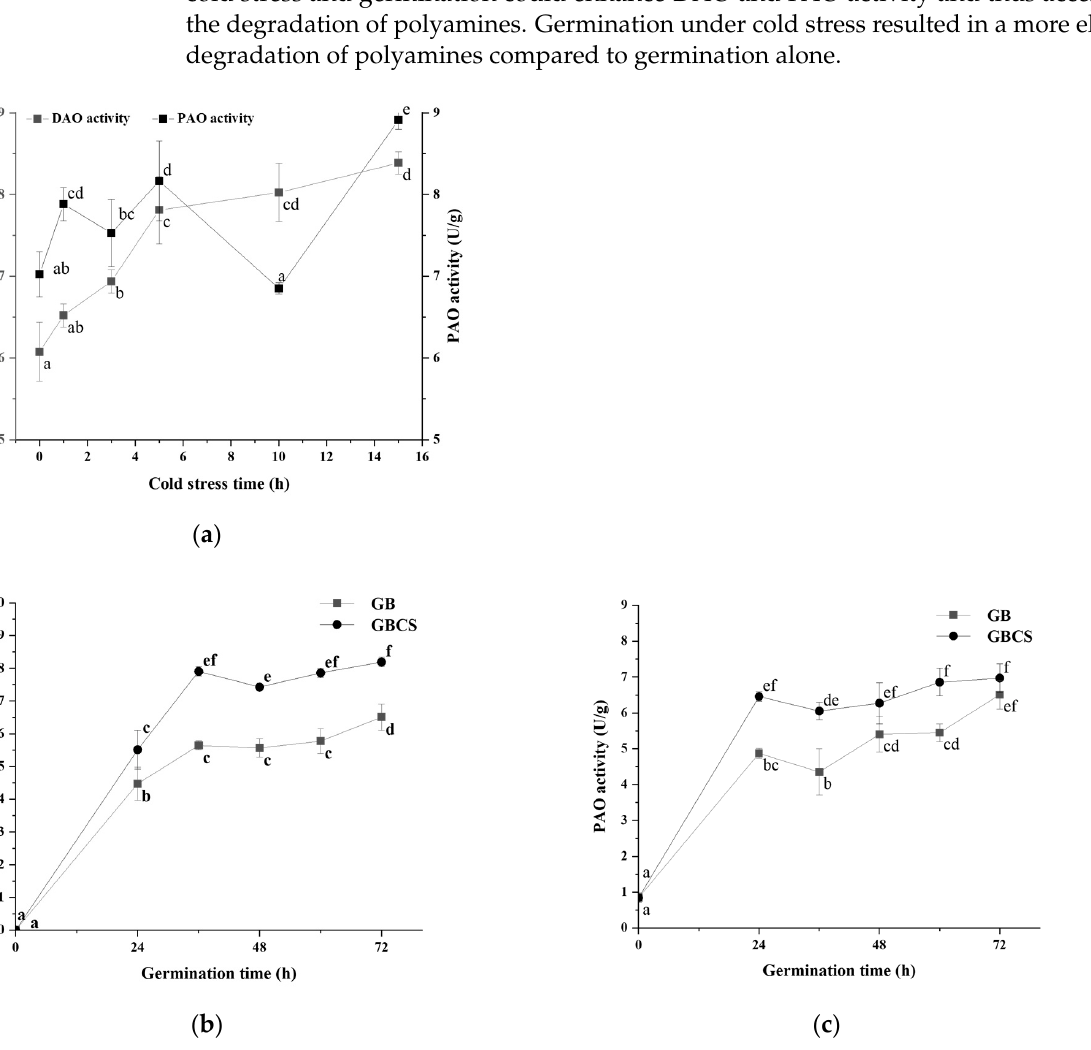
Figure 8. Change in DAO and PAO activity in fl uenced by cold stress and germination. GB, germi- nated black rice grain without cold stress; GBCS, germinated black rice grain under cold stress at 0 °C for 1 h; ( a ) represents the change in DAO and PAO activity in fl uenced by cold stress time; ( b ) represents the change in DAO activity in fl uenced by germination time with or without cold stress; ( c ) represents the change in PAO activity in fl uenced by germination time with or without cold stress. Means with di ff erent small le tt er superscripts are signi fi cantly di ff erent at p < 0.05.